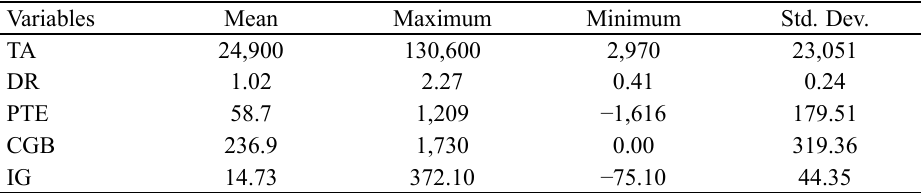
Table 1. Results of variables descriptive statistics